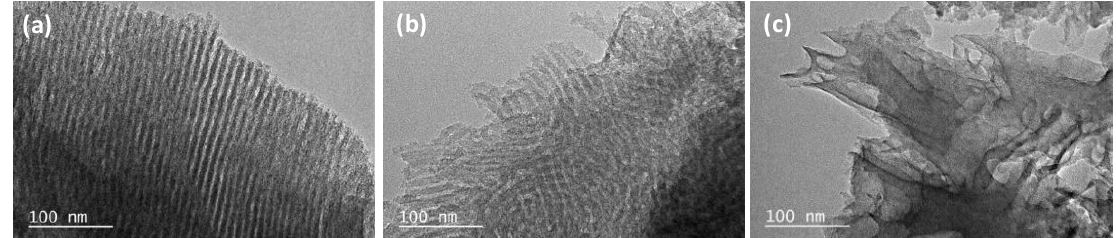
Figure 2. TEM images of carbon materials obtained by using different synthesis procedures: phase separation ( a ), stirring ( b ) and stirring/evaporation ( c ).